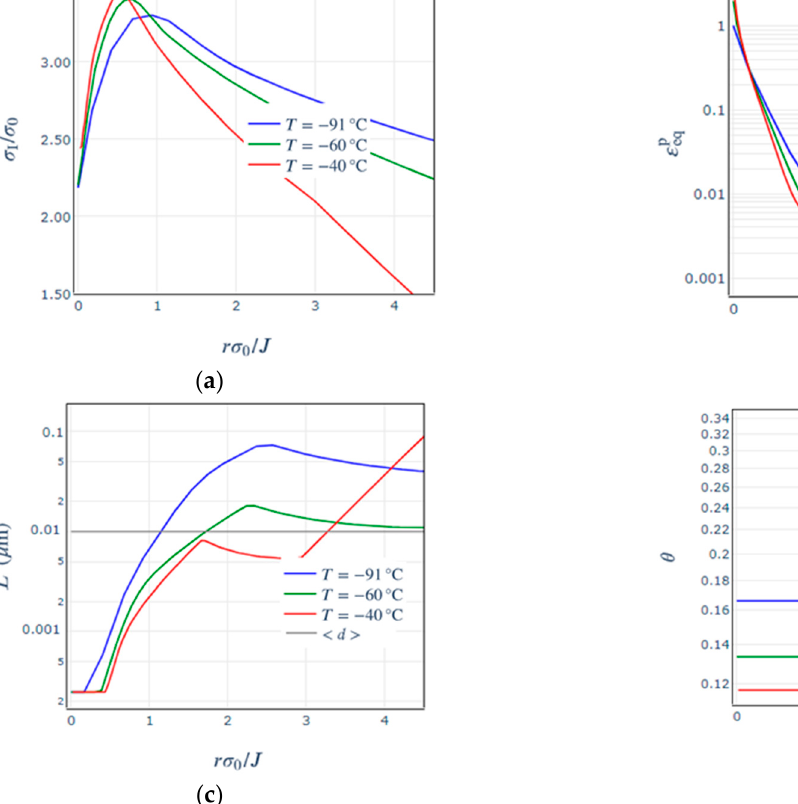
Figure 4. ( a ) Normalised maximum principal stress, ( b ) equivalent plastic strain, ( c ) critical length and mean interparticle distance; and ( d ) thinning as a function of the normalized distance from the crack tip for the 1T C(T) models at all temperatures.